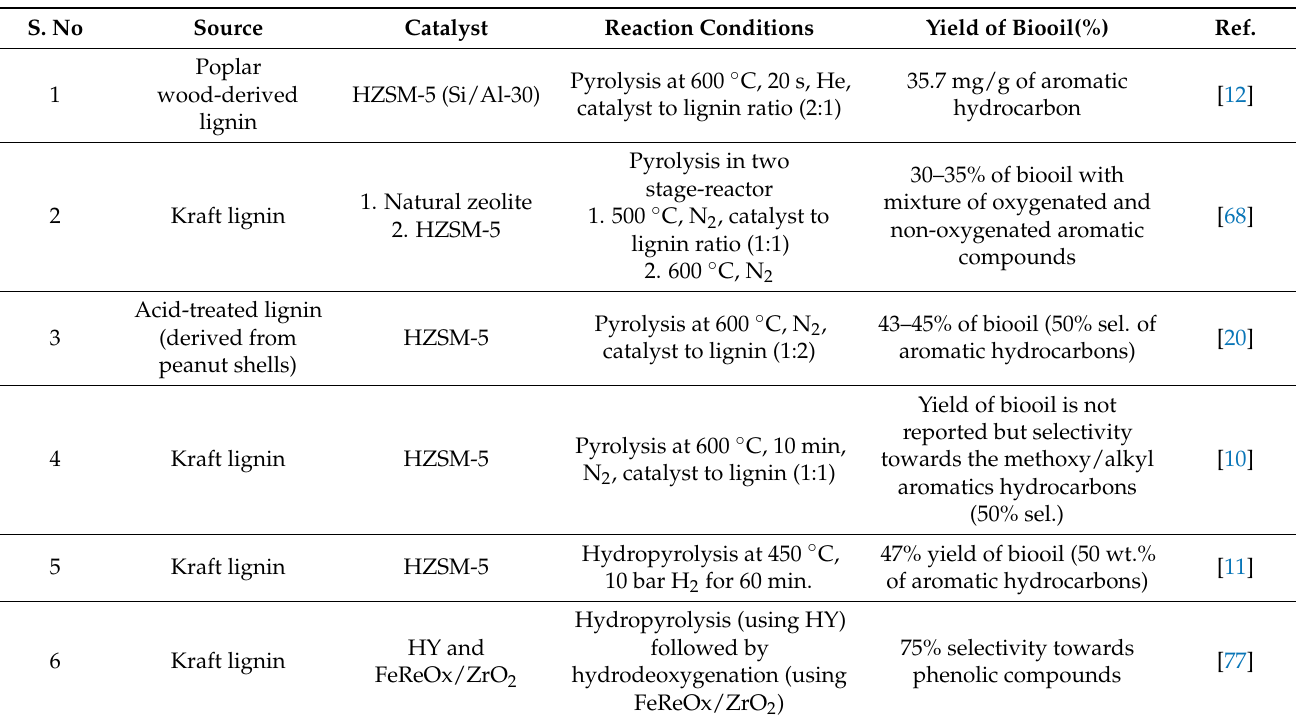
Table 1. Acid-catalyzed pyrolysis and hydropyrolysis of